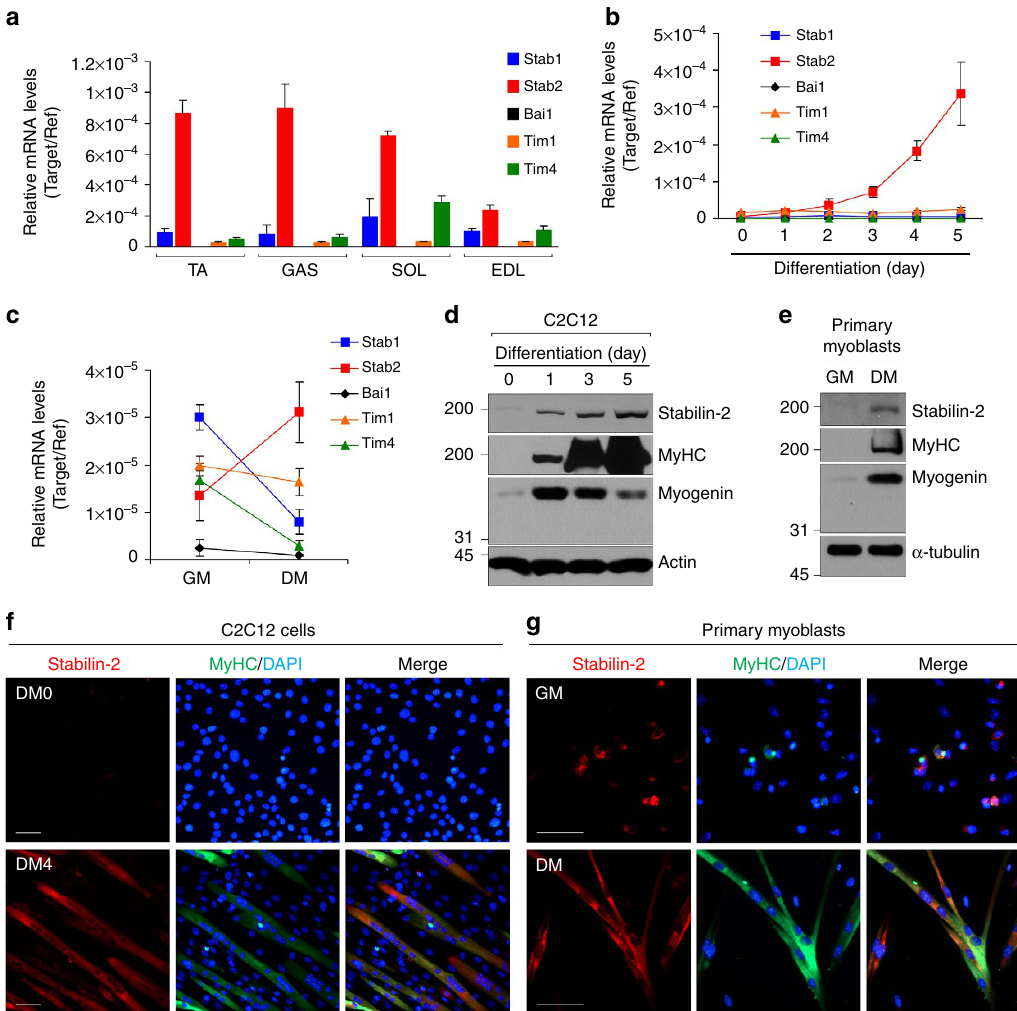
Figure 1 | Stabilin-2 expression in muscle tissues and during myogenic differentiation. ( a ) The expressions of PS-recognizing receptors (Tim1, Tim4, Bai1, stabilin-1 and stabilin-2) were examined in mouse skeletal muscles by quantitative real-time PCR. Data are presented as mean ± s.d. of at least three independent experiments. ( b , c ) Expression levels of PS-recognizing receptors were examined in C2C12 cells ( b ) and primary myoblasts ( c ) during myogenic differentiation by quantitative real-time PCR. Data are presented as mean ± s.d. of at least three independent experiments. GM, growth medium; DM, differentiation medium. ( d , e ) Expression levels of stabilin-2 protein were determined in C2C12 cells ( d ) and primary myoblasts ( e ) during myogenic differentiation by Western blotting. Representative results from three independent experiments are shown. MyHC, myosin heavy chain. Full-size blots are shown in Supplementary Fig. 15. ( f , g ) C2C12 cells ( f ) and primary myoblasts ( g ) were induced to differentiate in differentiation medium (DM), and the expressions of stabilin-2 and myosin heavy chain (MyHC) were analysed at the indicated times by immunostaining. Scale bar, 50 m